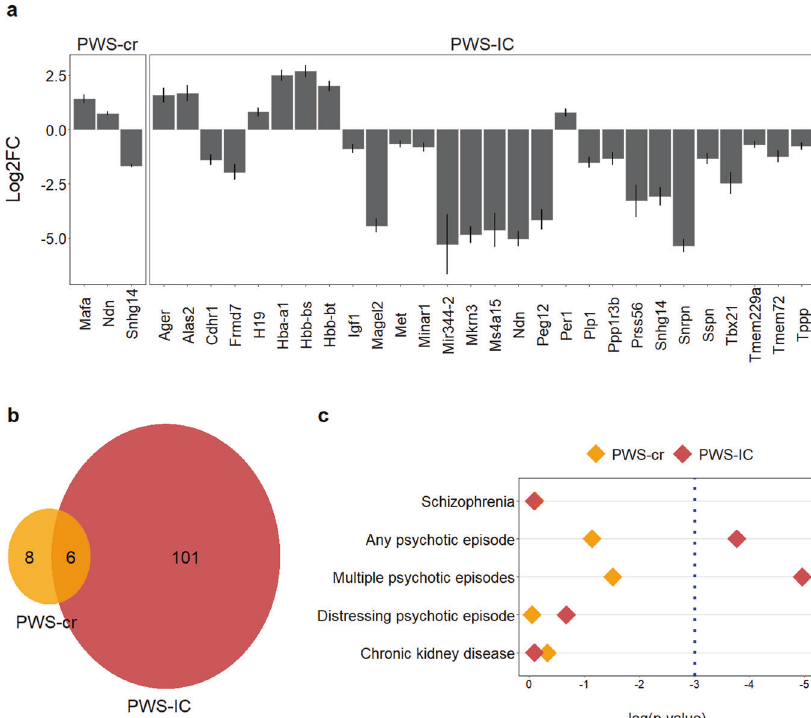
Fig. 5 RNA-sequencing assay. Differential gene expression analysis ( a ) showed overexpression of Necdin and Mafa in the PWS-cr tissue, as well as an expected loss of expression of the long non-coding RNA Snhg14 that acts as a host for the critical interval. Among the differentially expressed genes in the PWS-IC tissue were the genes from the PWS locus, and notably the circadian clock regulator Per1 and the insulin growth factor Igf1 . Predicted genes of unknown function were excluded from the graph. The y axis on this graph ( a ) shows log2 fold change of expression, error bars indicate standard error of the mean. Differentially expressed genes and isoforms were pooled for enrichment analyses; PWS-cr and PWS-IC pooled genes had 6 genes in common ( b ). Gene set analysis of pooled differentially expressed genes and isoforms ( c ) showed signi fi cant enrichment of common genetic variants associated with the experience of psychotic episodes, but not schizophrenia. GWAS summary data from a chronic kidney disease study was used as a negative